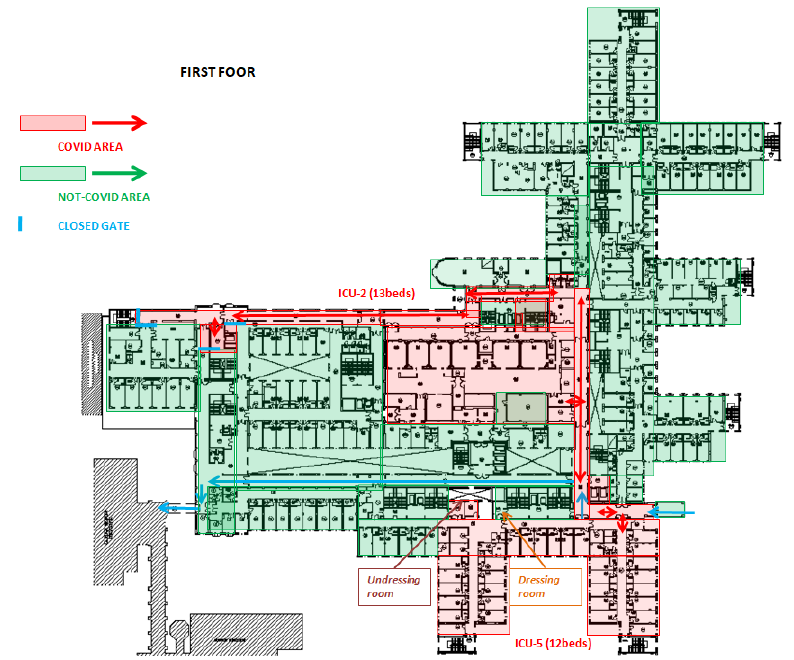
Figure 3. Planimetry of the first floor of Cisanello hospital sector, where the COVID areas (in red) were set up.